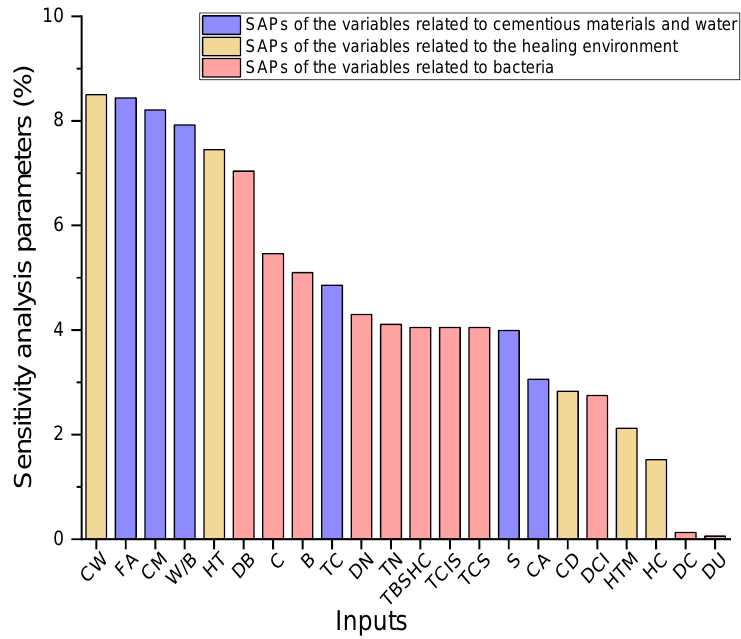
Figure 4. SAPs of the variables.